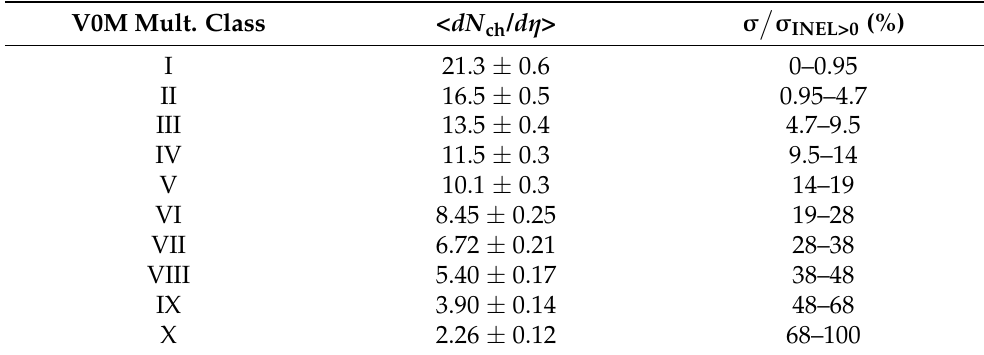
Table 1. The mean charged-particle multiplicity density and fraction of inelastic cross-section in ten multiplicity groups in inelastic proton-proton collisions at ( s ) 1/2 = 7 TeV. V0M Mult.